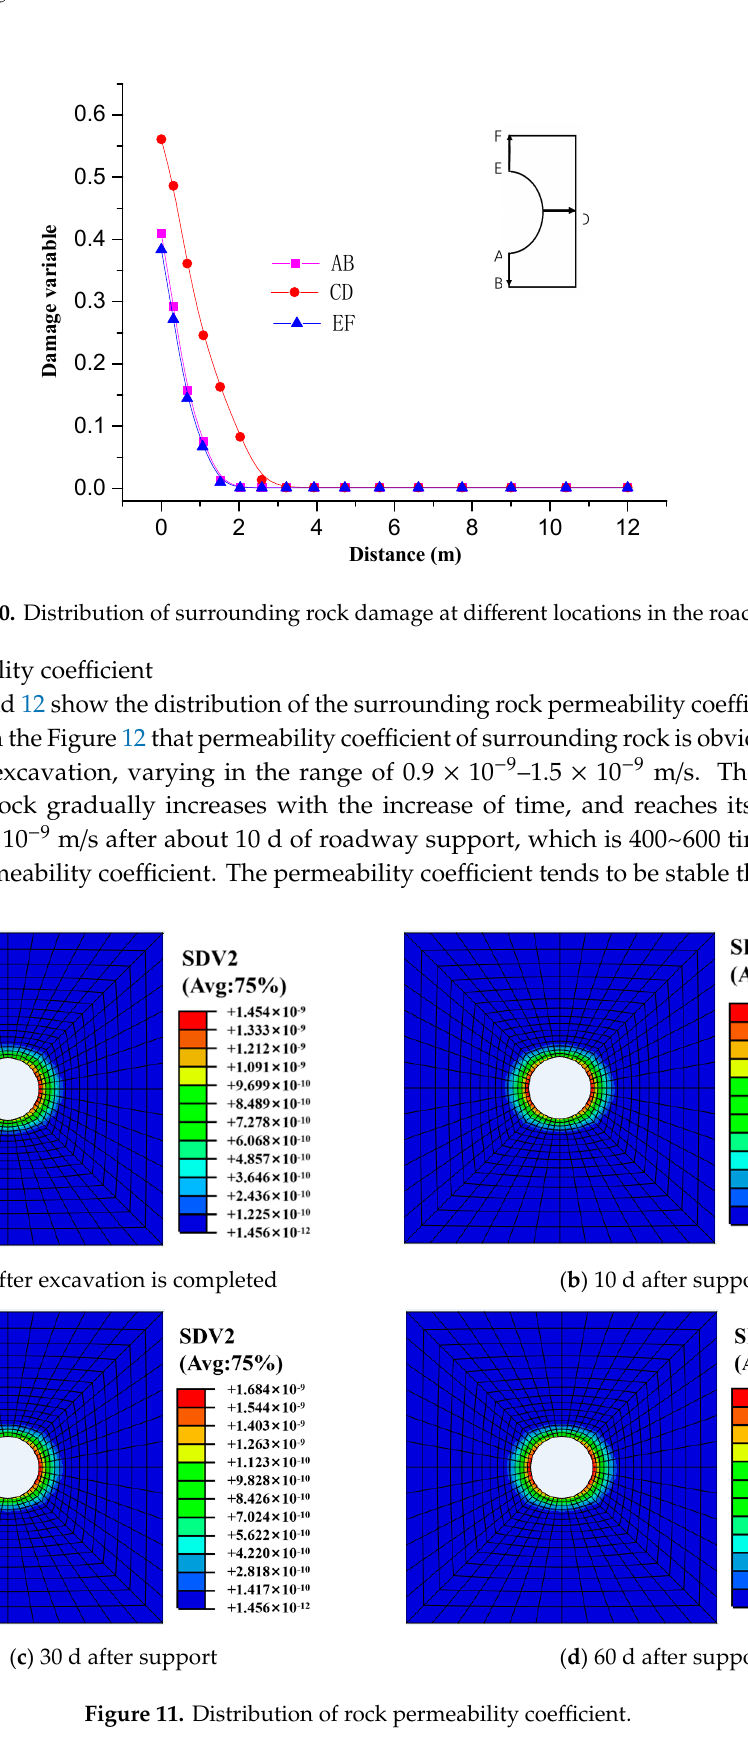
Figure 9. Distribution curve of surrounding rock damage over time.